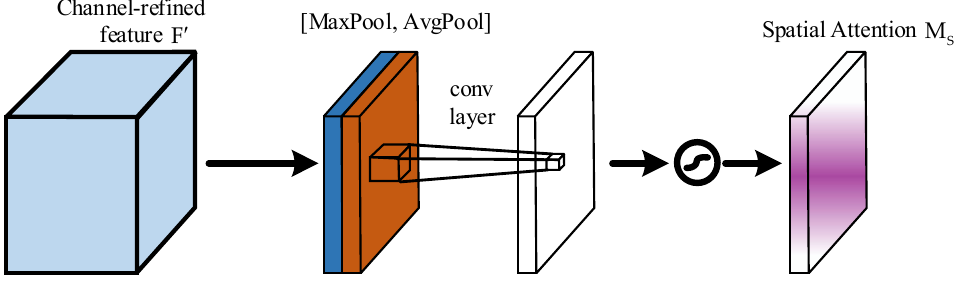
Figure 6. The network structure of SAM.